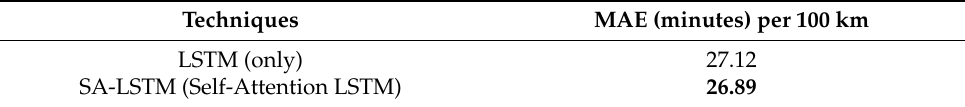
Table 4. Performance report of comparison of the LSTM and SA-LSTM.